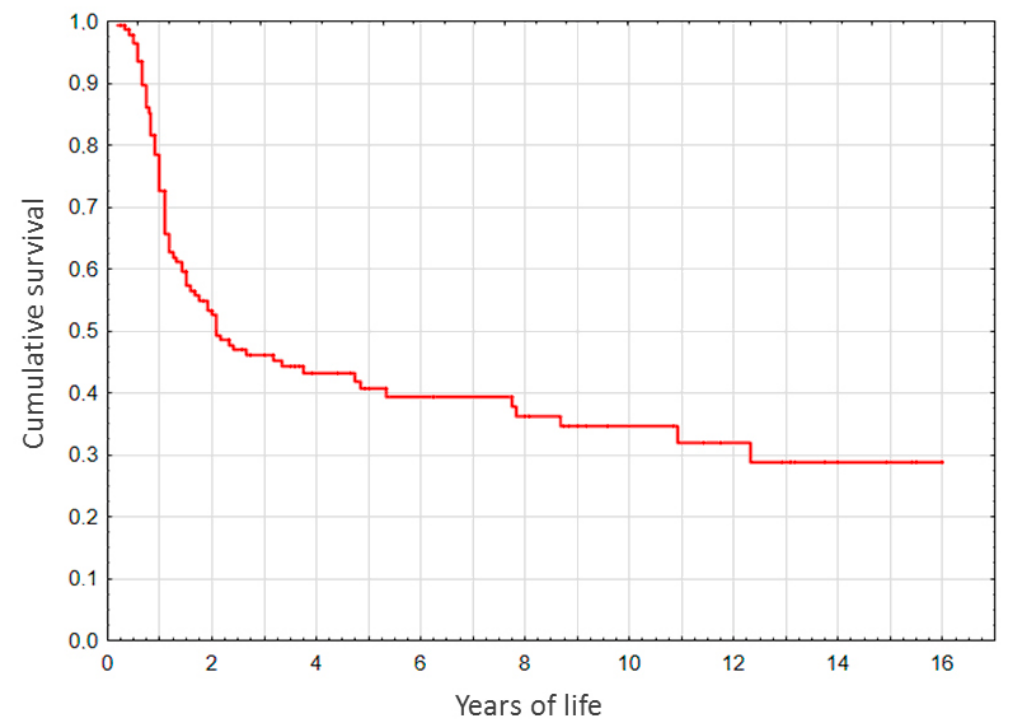
Figure 2. Survival with native liver (non-LT subgroup) after Kasai surgery.